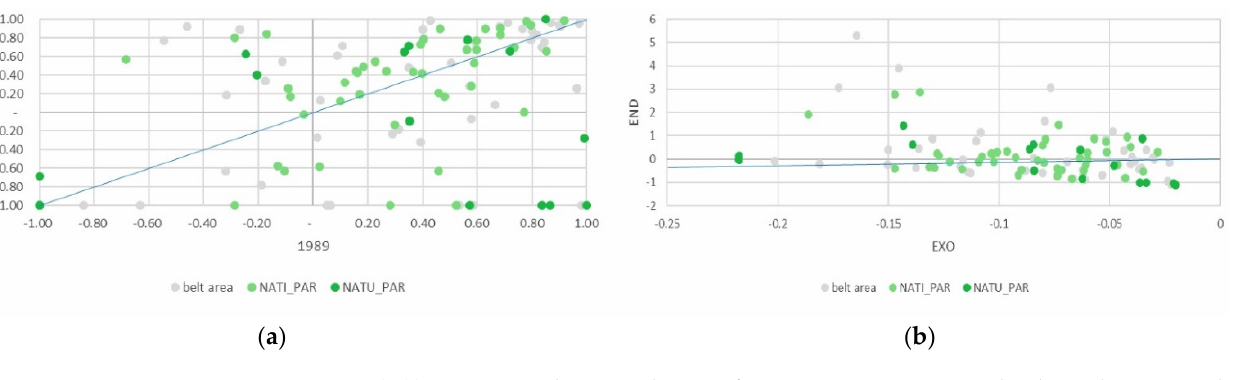
Figure 12. ( a , b ) Sierra Nevada- PSI and DPSI of goats. Source: Drawn up by the authors using data from the 1989 and 2009 Agrarian Censuses, Ministry of Agriculture.